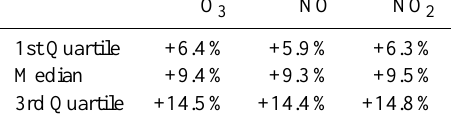
Table 4. Relative difference between AGM fluxes (of O 3 , NO and NO 2 ) determined using the stability functions proposed by Dyer and Hicks (1970) and those proposed by Businger et al. (1971) and modified by H¨ogstrom (1988). Positive values in- dicate greater fluxes using the stability functions proposed by Dyer and Hicks (1970). O 3 NO NO 2 1st Quartile +6.4% +5.9% +6.3% Median +9.4% +9.3% +9.5% 3rd Quartile +14.5% +14.4%